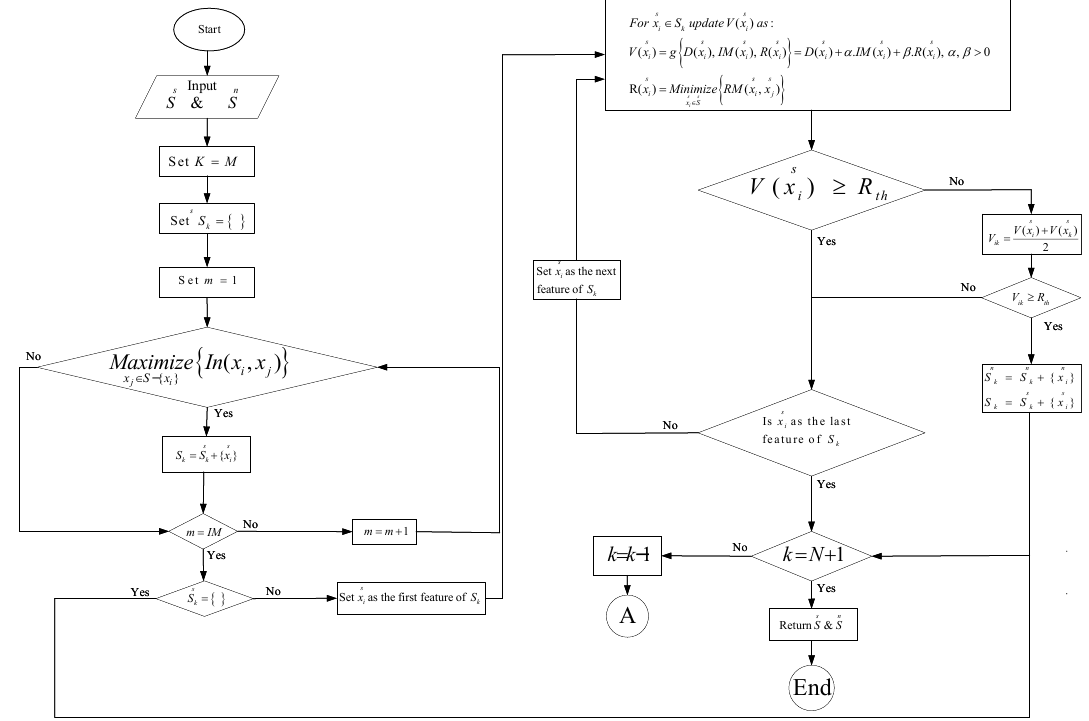
Figure 4. Flow chart of the post-filtering